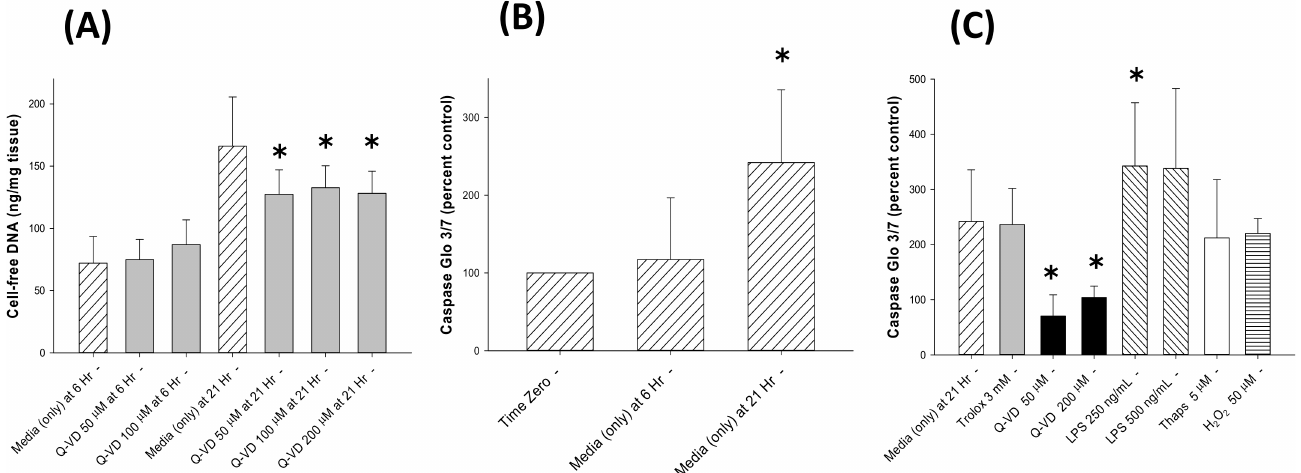
Fig 3. A) Cell-free DNA response to Q-VD-OPh: Bar graphs demonstrating cell-free DNA (cfDNA) release into the culture media by mouse placental explantscultured in 21% O 2 conditions at 6 hours and 21 hours in the presenceof tissue culture media alone (hatched bars) or Q-VD-OPh (a pan- caspase inhibitor,gray bars); data reported in mean ± S.D., N = 6–57, and * = p < 0.05 comparedto culture media alone at 21 hours. B) Caspase3/7 response over time: Bar graph demonstrating caspase 3 and 7 activity (by CaspaseGlo 3/7 assay) in tissue homogenates of placentalexplants cultured in 21% O 2 conditions at 6 hours and 21 hours in the presenceof tissue culture media alone; data reportedin mean ± S.D., N = 5–12, and * = p < 0.05 comparedto time zero. C) Caspase 3/7 responseto trolox, Q-VD-OPh, LPS, thapsigargin & hydrogenperoxide:Bar graph demonstrating caspase 3 and 7 activity in tissue homogenates of placentalexplantsculturedin 21% O 2 conditionsat 21 hours in the presenceof tissue culture media alone (broad hatchedbars), trolox (gray bar), Q-VD-OPh (black bars), LPS (narrow hatchedbars), thapsigargin(open bar) and hydrogen peroxide(H 2 O 2 , horizontalhatchedbars); data reportedin mean ± S.D., N = 4–12, and * = p < 0.05 comparedto culture media alone at 21 hours.